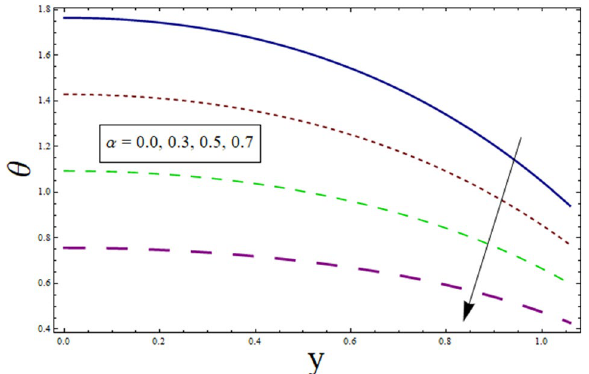
Figure 2. Temperature presentation of α.